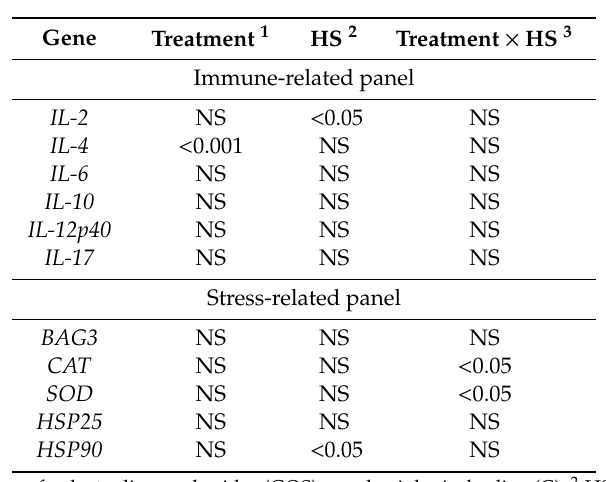
Table 4. E ff ects of in ovo treatment and the duration of heat stress (HS) on gene expression signatures in the spleens of slow-growing chickens.